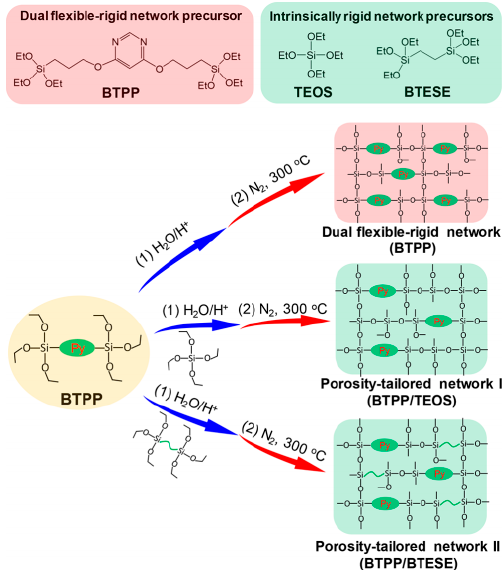
Figure 10. A porosity-tailored network via the co-condensation of a dual flexible − rigid network of BTPP and rigid network of TEOS and BTESE. Reproduced from [109] .